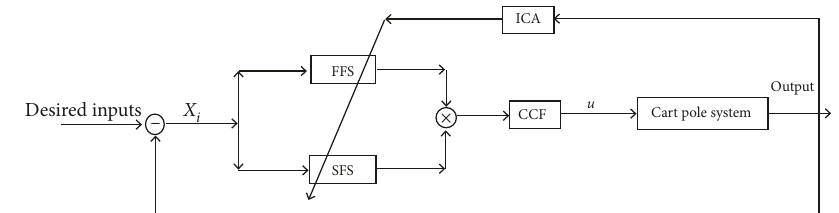
Figure 3: Flowchart of the ICA.